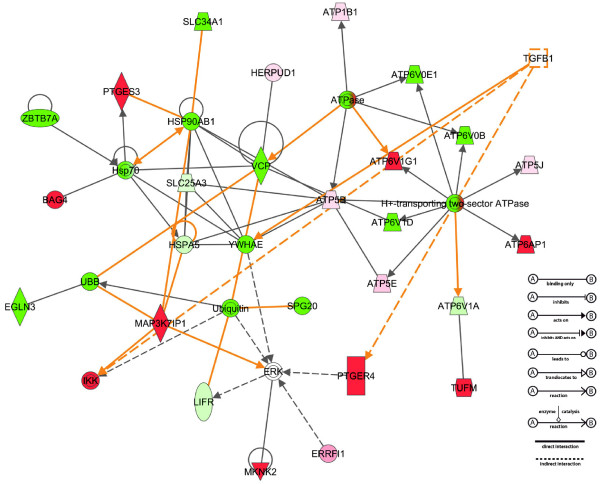
Ingenuity Pathway analysis generated Network 1 diagram. The networks are based on known protein-protein interactions and functional relations. Genes that are differentially expressed in the SAGE libraries are depicted in shades of red (upregulated) or green (downregulated); empty symbols represent network genes that were not differentially expressed in the SAGE libraries. TGFβ is inserted into the model to identify gene whose expression is modulated by TGFβ. The diagram to the right explains the relationship lines.